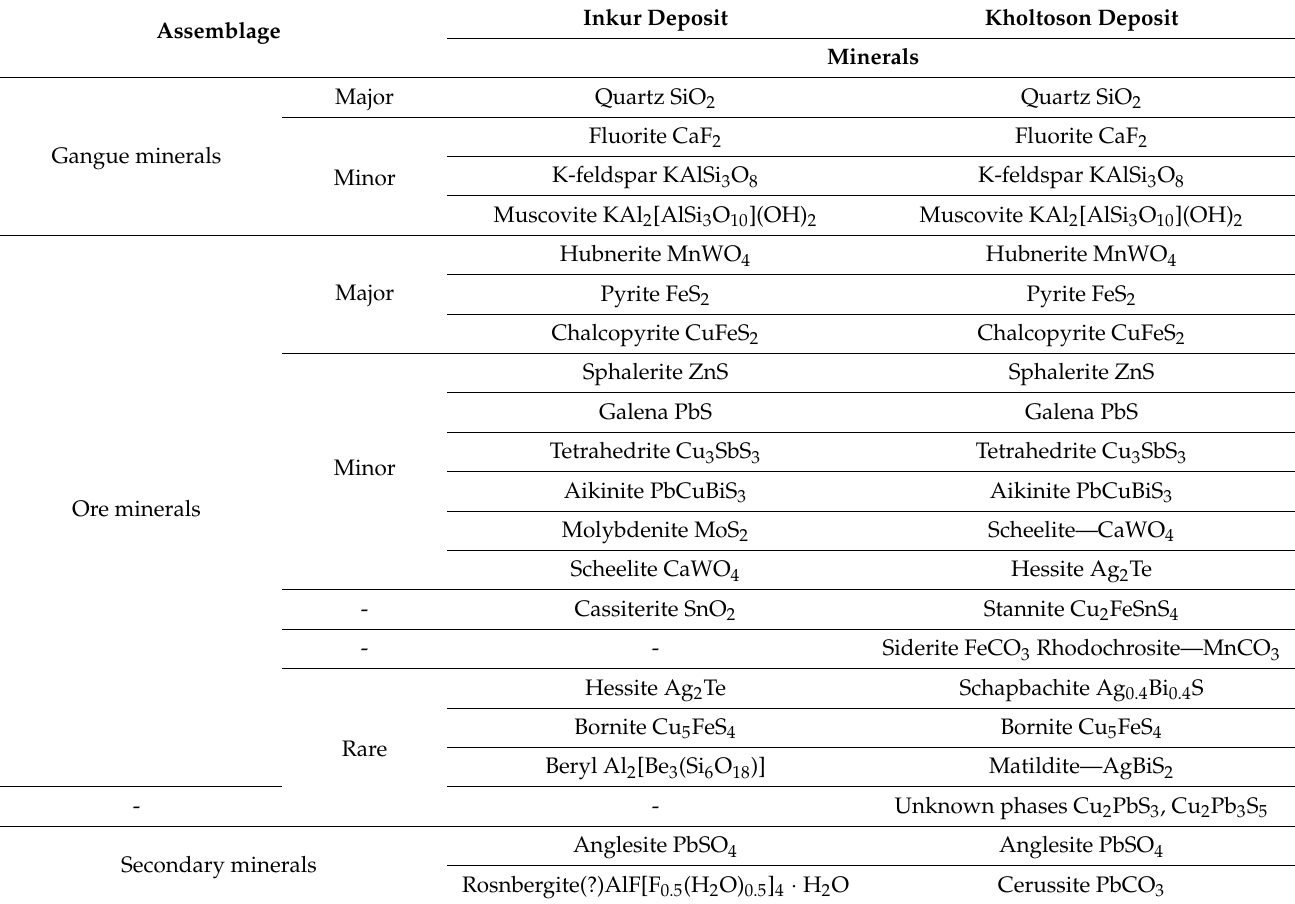
Table 1. Bulk mineral composition of quartz-hubnerite veinlets of the Inkur and quartz-sulfide-hubnerite veins of the Kholtoson deposits. Inkur Deposit Kholtoson Deposit Assemblage Minerals